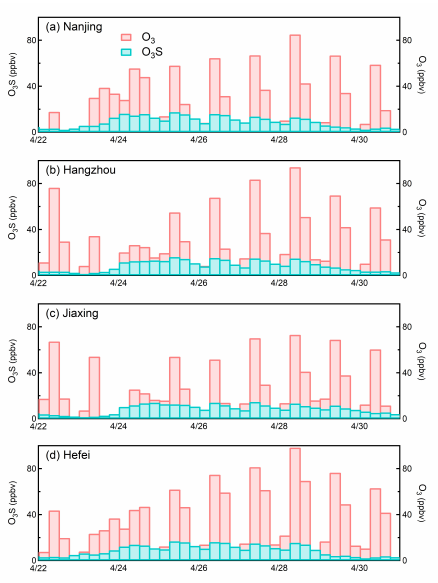
Figure 13. Time evolution of CAM-Chem simulated ozone (red) and O 3 S (turquoise) in eastern China from 22 April 2018 to 30 April 2018. ( a ) Nanjing, ( b ) Hangzhou, ( c ) Jiaxing and ( d )